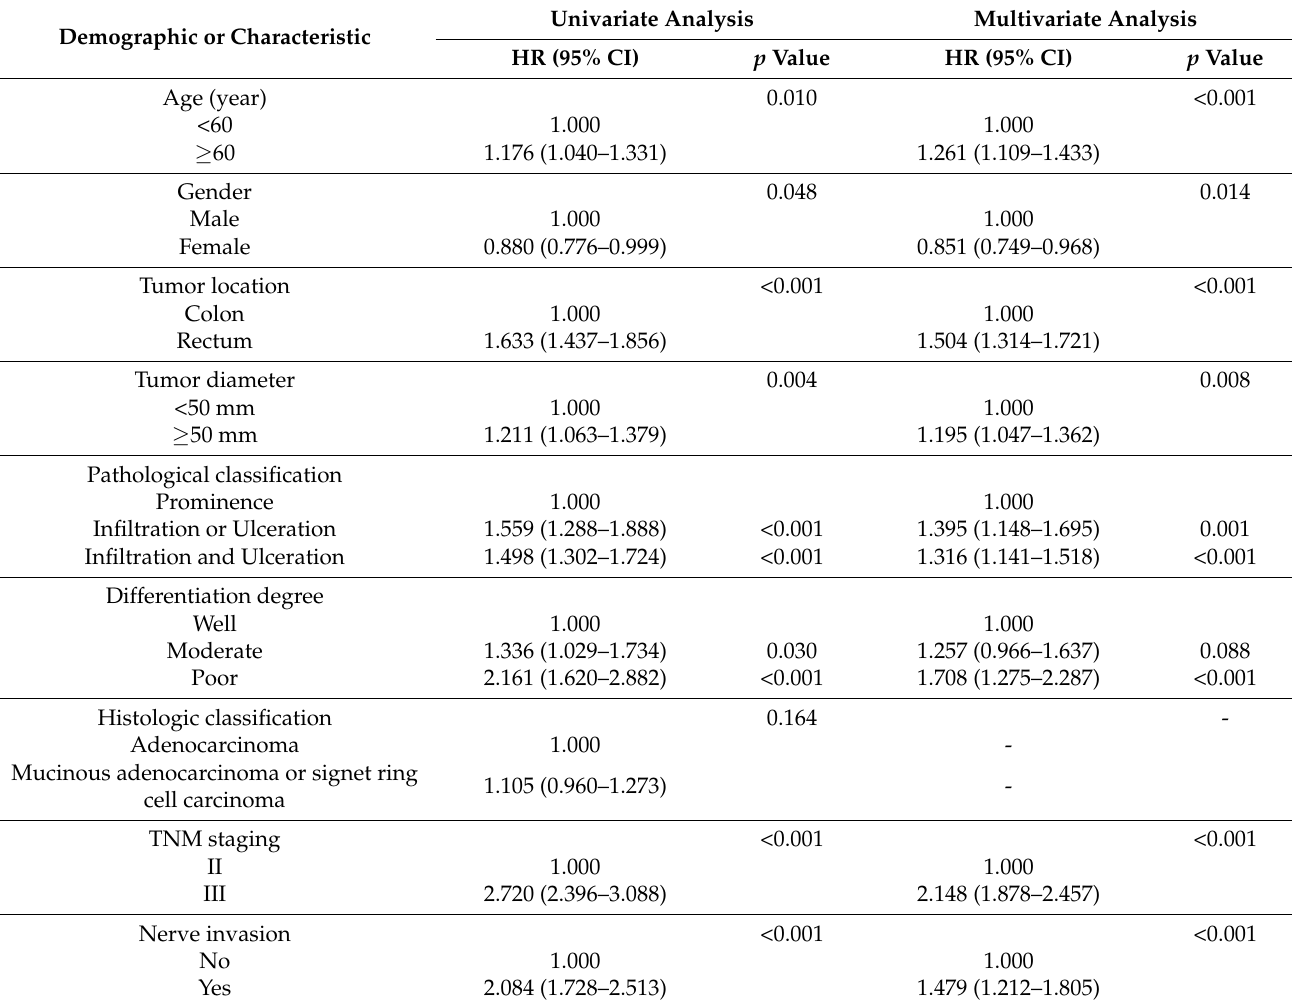
Table 3. Association between predictive factors and disease-free survival of CRC in the training cohort. Demographic or